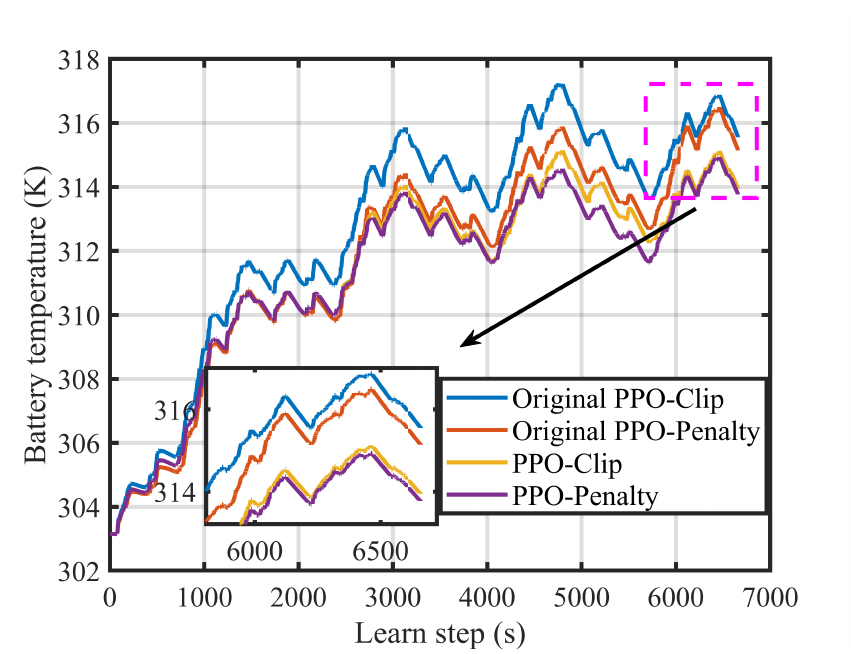
Figure 16. Battery temperature rise curves in 4 × WVUSUB. Table 7. The simulation results of battery temperature in 4 × WVUSUB.